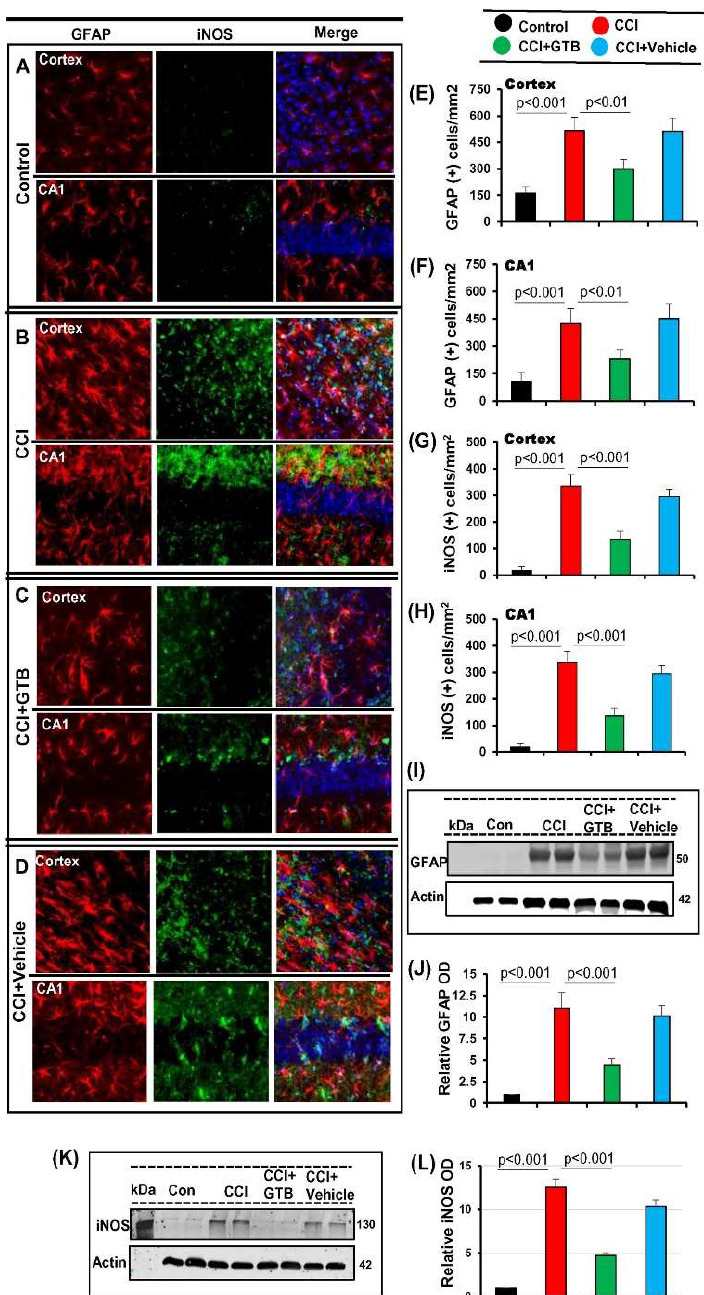
Figure 1. Oral administration of GTB inhibits astroglial inflammation in vivo in the cortex and hippocampus of mice with TBI. TBI was induced in mice by CCI injury and after 24 h of injury mice were treated with 50 mg/kg/day of GTB via oral gavage. Seven days after GTB treatment, brain sections were double labeled for GFAP and iNOS (( A ), control; ( B ), CCI; ( C ), CCI + GTB; ( D ), CCI + Vehicle). Cells positive for GFAP were counted in cortex ( E ) and CA1 region of hippocampus ( F ). Similarly, cells positive for iNOS were also counted in cortex ( G ) and CA1 region ( H ). Results represent analysis of six sections of each of six mice per group. Tissue extracts of hippocampal region from all groups of mice (n = 4 per group) were immunoblotted for GFAP ( I ) and iNOS ( K ). Actin was run as a loading control. Bands were scanned, and values (GFAP/Actin) ( J ) and (iNOS/Actin) ( L ) presented as relative to control.